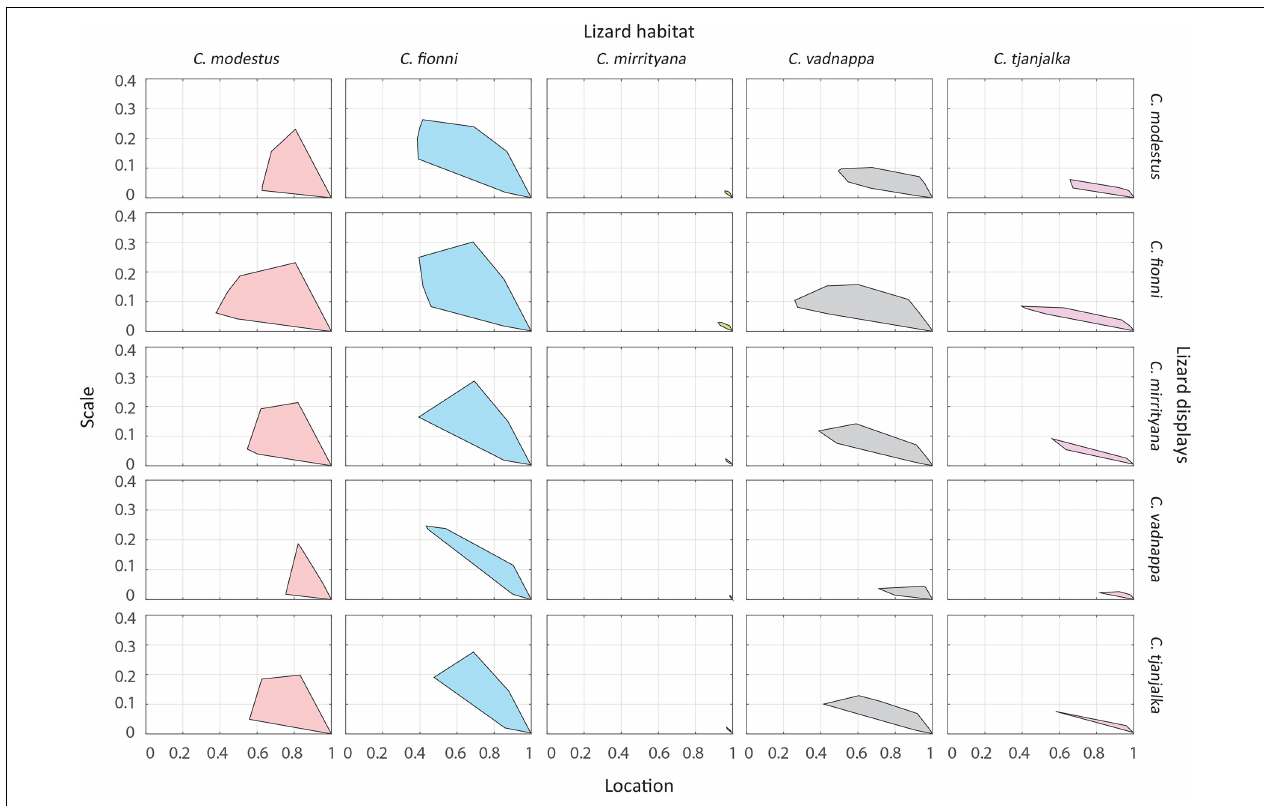
FIGURE 7 | Relative contrast of signals and noise for all species at all habitats. Each convex hull represents all the contrast values of all signals against all plants and views for a particular species at a particular habitat. The location ( x axis) shows the central tendency of the contrast value, while the scale ( y axis) shows the variation around the central tendency. A location value close to 1 and a scale value close to 0 indicate that display movements are much faster than plant movements. Large convex hulls indicate that there is high variability in signal contrast at the site, with some areas showing high contrast and others low